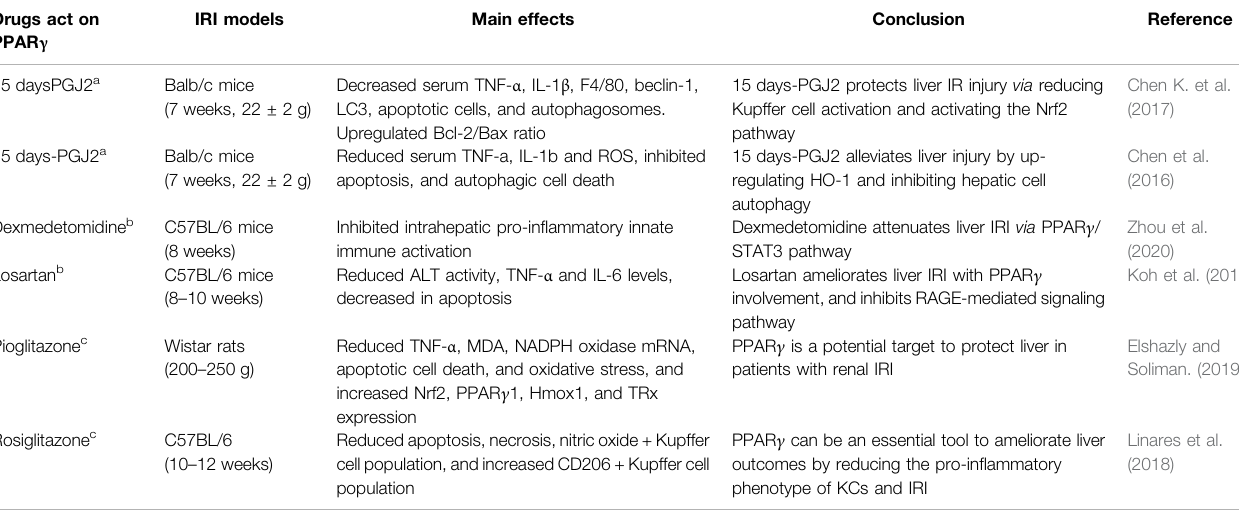
TABLE 2 | Summarization of the effects of drugs acting on PPAR γ in hepatic